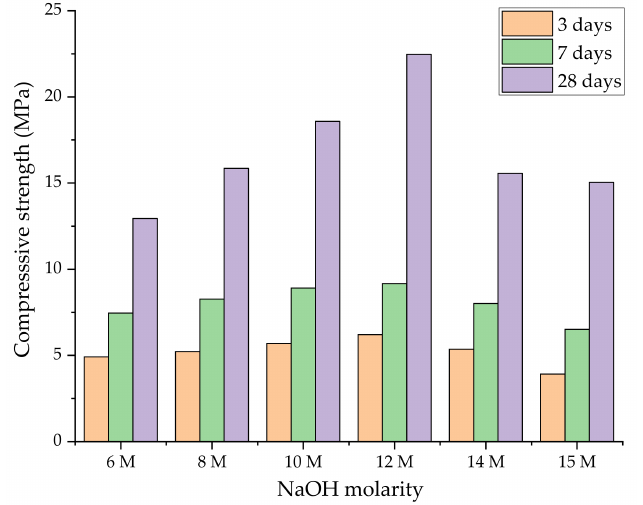
Figure 4. Effect of activating solution molarity on strength performance of FA geopolymer